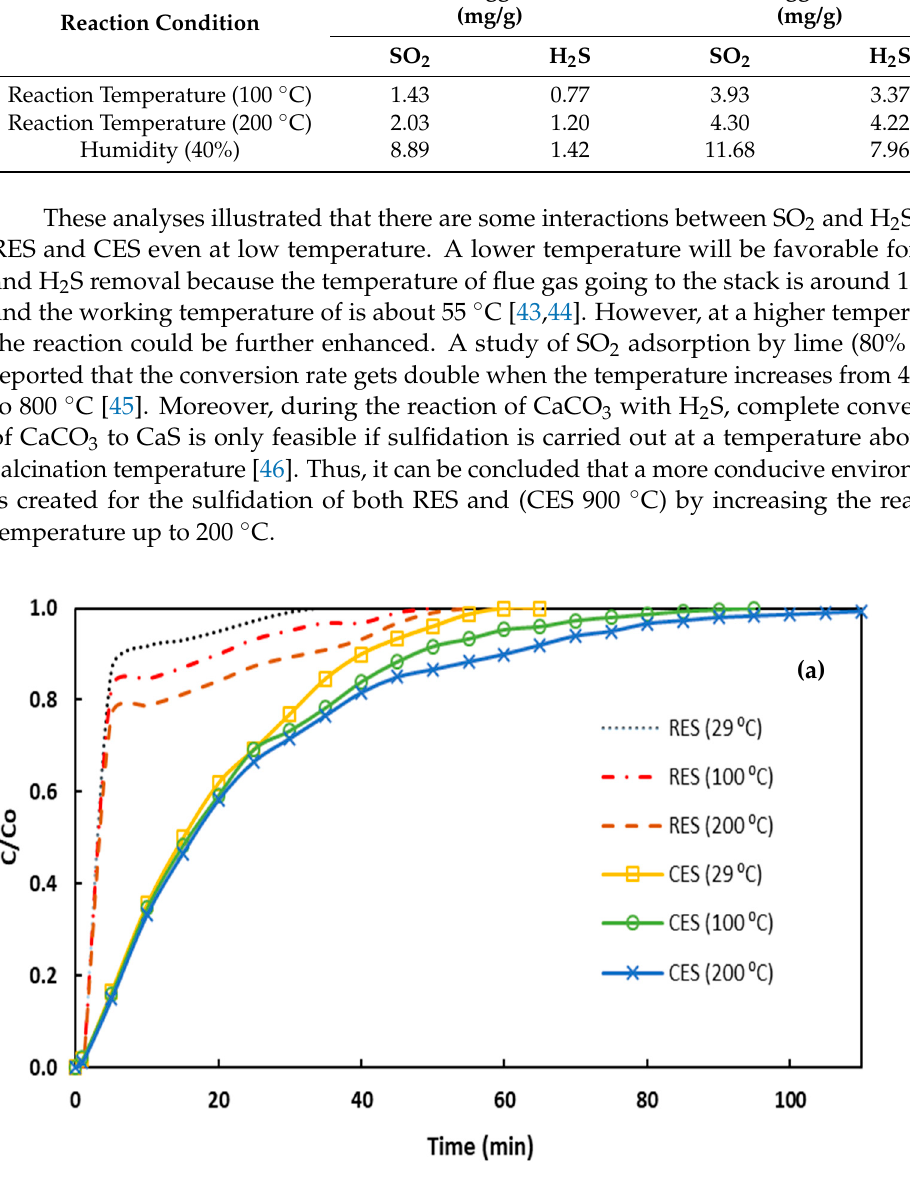
Figure 7. Breakthrough curves of ( a ) SO 2 and ( b ) H 2 S at different reaction temperature. Figure 8 shows the breakthrough curves of RES and (CES 900 °C) with a response to the effect of humidity. All other parameters were kept constant. It was noticed that with the addition of 40% relative humidity (RH), the performance of both RES and (CES 900 °C) improved significantly. The adsorption capacity of SO 2 and H 2 S by (CES 900 °C) in- creased almost triple with humidity. There were significant improvements in the break- through time as well as saturation time for both SO 2 and H 2 S. The breakthrough point was clearly noticeable for (CES 900 °C). For RES, a great increase was noticed for SO 2 , however, for H 2 S, only small improvement was noticed. Results can be compared from Table 4–6. The presence of humidity in the inlet gas improved the adsorption capacity of SO 2 more than the H 2 S for RES. This could be due to the solubility of SO 2. The solubility of SO 2 in water is about 16 times more than the solubility of H 2 as per the data published by [47]. The chemical reaction of SO 2 and CaCO 3 in the presence of RH is as shown below;